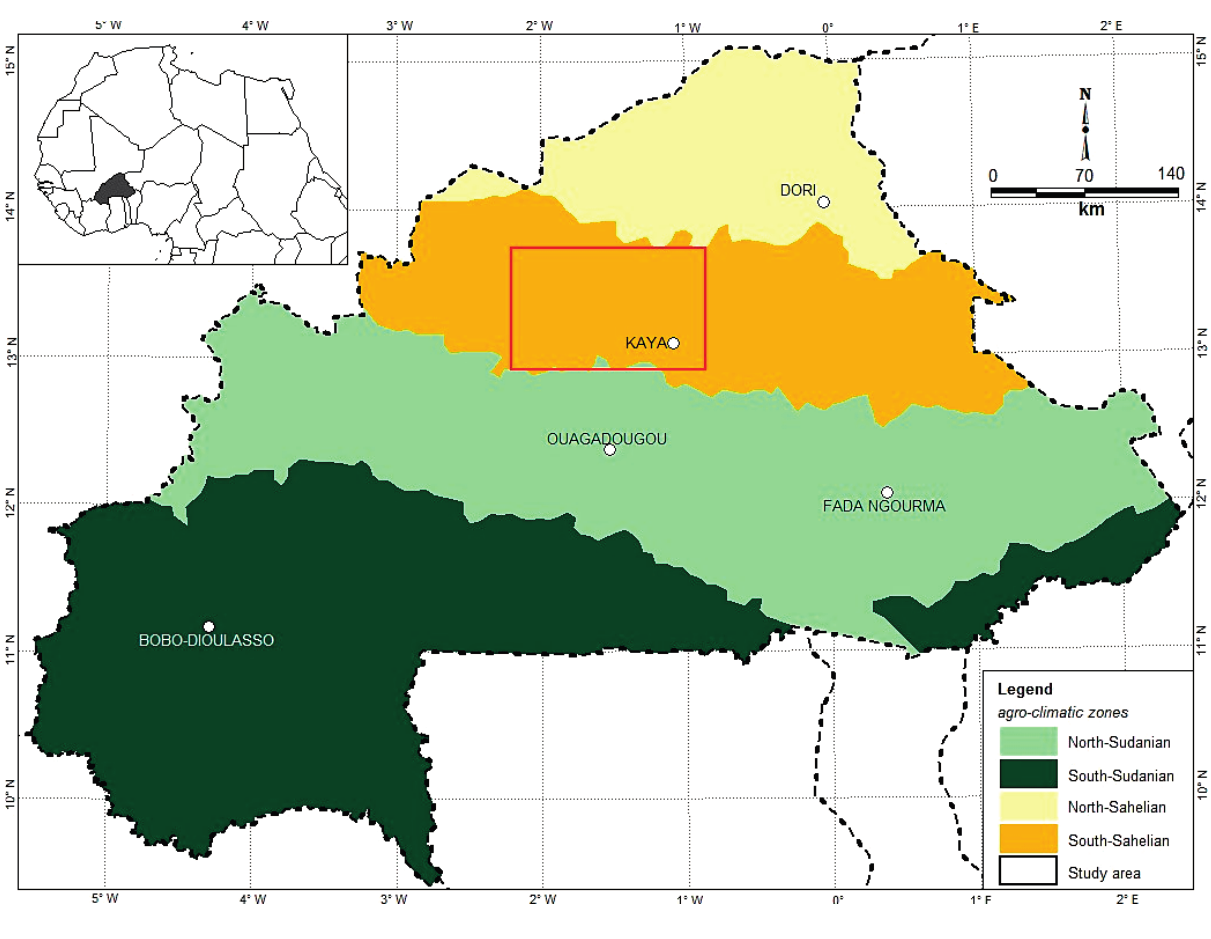
Figure 1. Study area (adapted from Ouedraogo